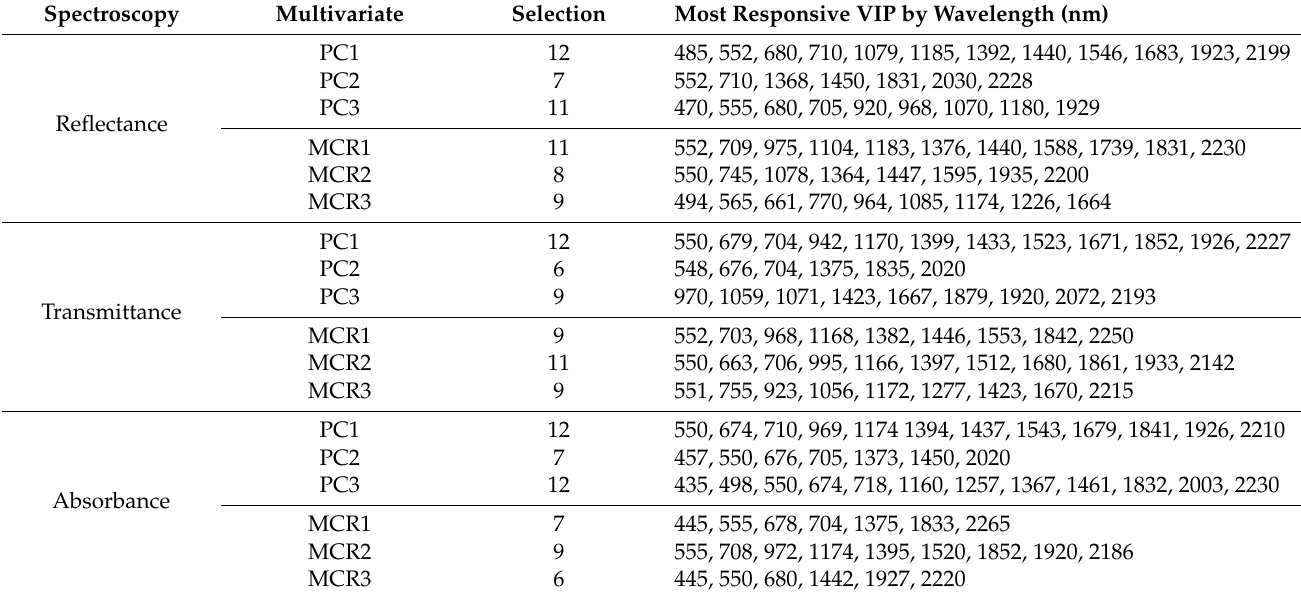
Table 2. Most responsive variable importance for projection (VIP) values by wavelength selected according to the first three regression coefficients for principal component (PC) and multivariate curve resolution (MCR) components by spectroscopy from reflectance, transmittance, and absorbance of